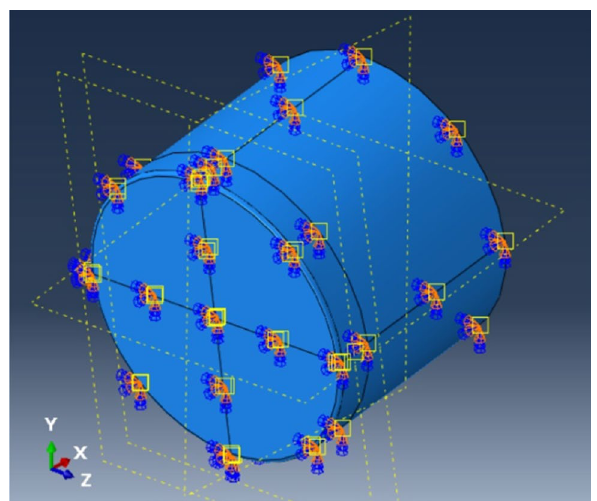
Fig. 4 Boundary conditions on the bottom of formation